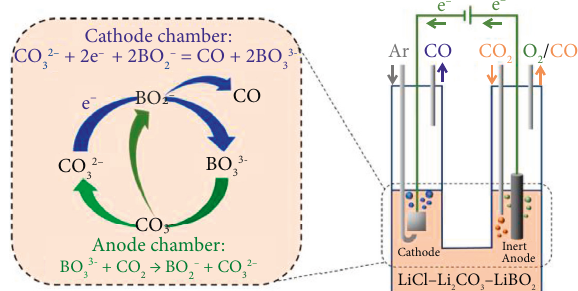
Figure 3: Main electrochemical directions of CO nonaqueous medium.